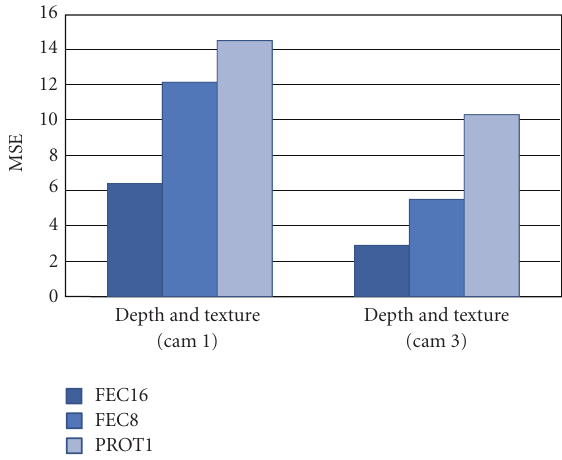
Figure 20: Performance with 10% packet loss rate on both texture and geometry: distortion due to packet losses with di ff erent error protection